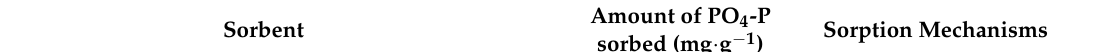
Table 3. P removal efficiency and sorption mechanisms by different biochar